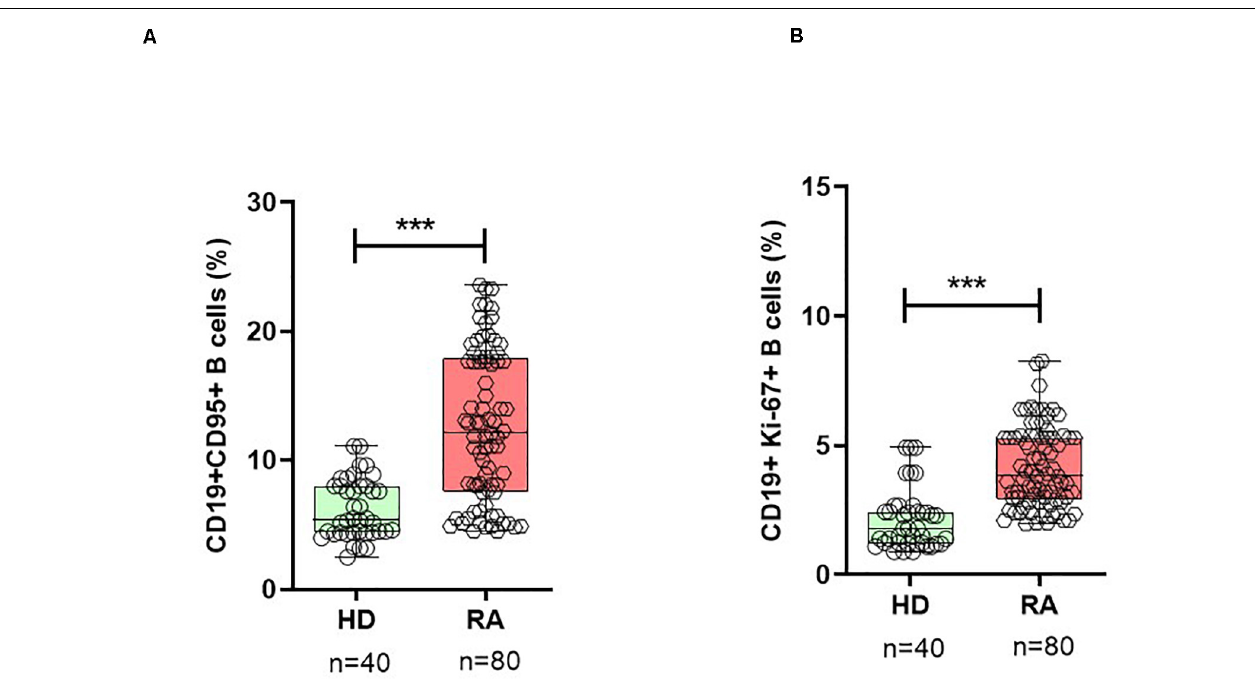
FIGURE 1 | Activated B cells are expanded in RA. In patients with RA patients, B cells show a significantly higher percentage of surface CD95+ (A) and intracellular Ki-67+ (B) expressing B cells when compared with healthy donors (HD). Data are shown in box-whisker plots showing individual dots, where boxes represent 25th to 75th percentiles and the lines within the boxes represent the median. P values were determined with the Student’s unpaired t -test using GraphPad Prism 6 (*** P < 0.0001). n = number of